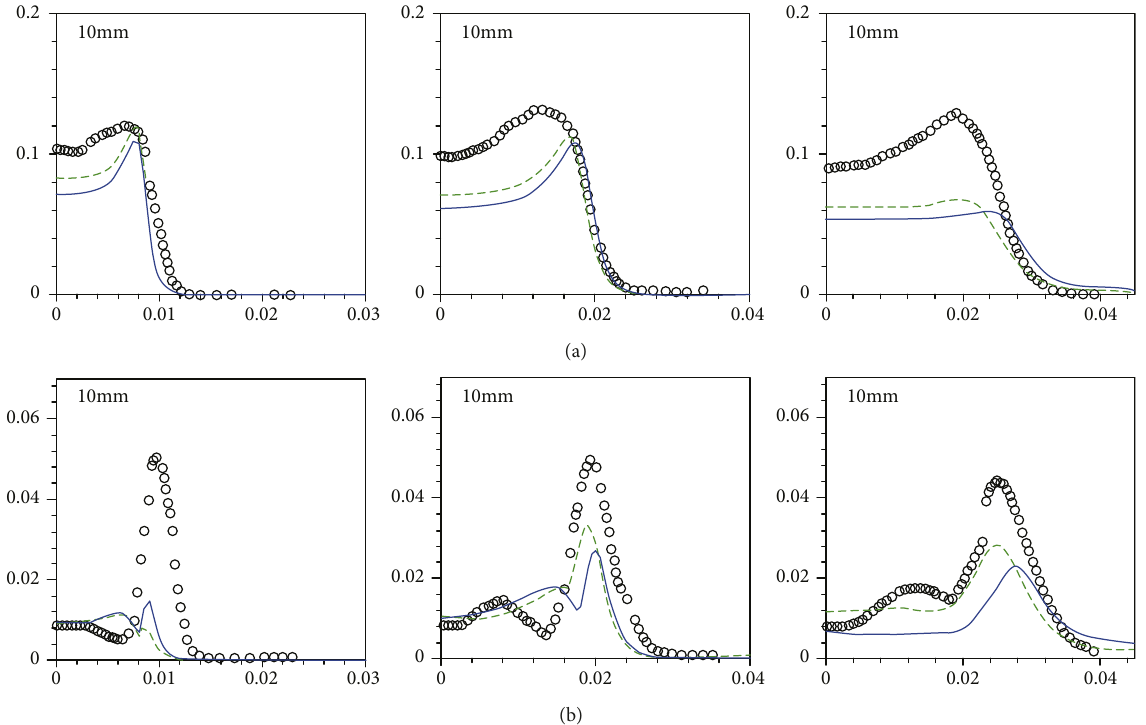
Figure 11: Comparison of mean (a) and rms (b) CO line, Mech I simulation; solid line, Mech II